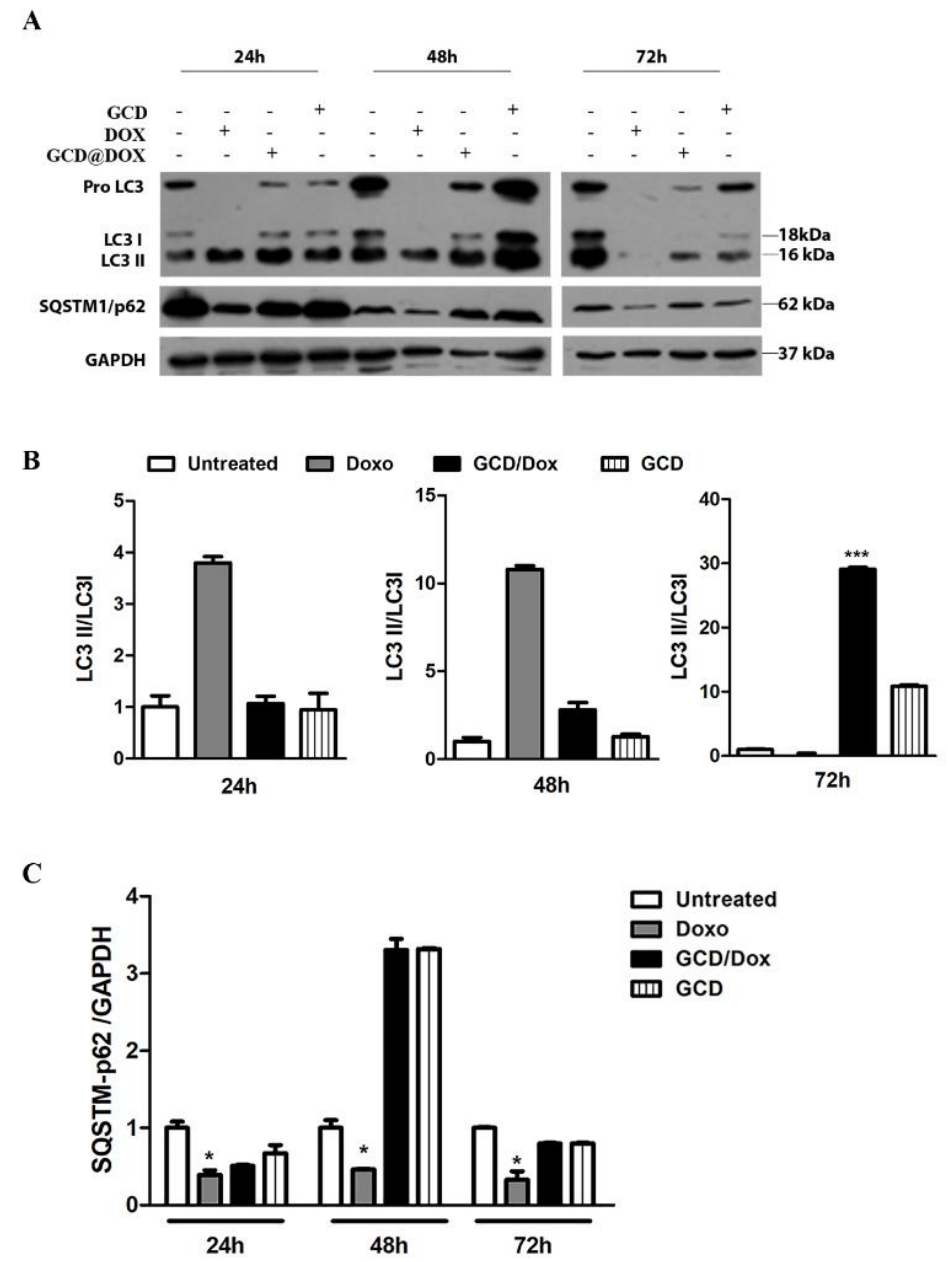
Figure 5. Parallel monitoring of LC3-I, LC3-II and SQSTM-p62 autophagy-related protein expres- sion in HEp-2 cells treated with GCD@DOX and DOX. ( A ) Immunoblot and quantification of LC3- I, LC3-II and SQSTM-p62 in HEp-2 cells untreated or treated with GCD@DOX, DOX and GCD for the indicated times. ( B , C ) The graphs show (mean ± SD) LC3-II/LC3-I ratios of each treatment nor- malised to the LC3-II/LC3-I ratio of control-untreated cells for each experiment. Statistical signifi- cance was tested by one-way ANOVA analysis assay in triplicate.